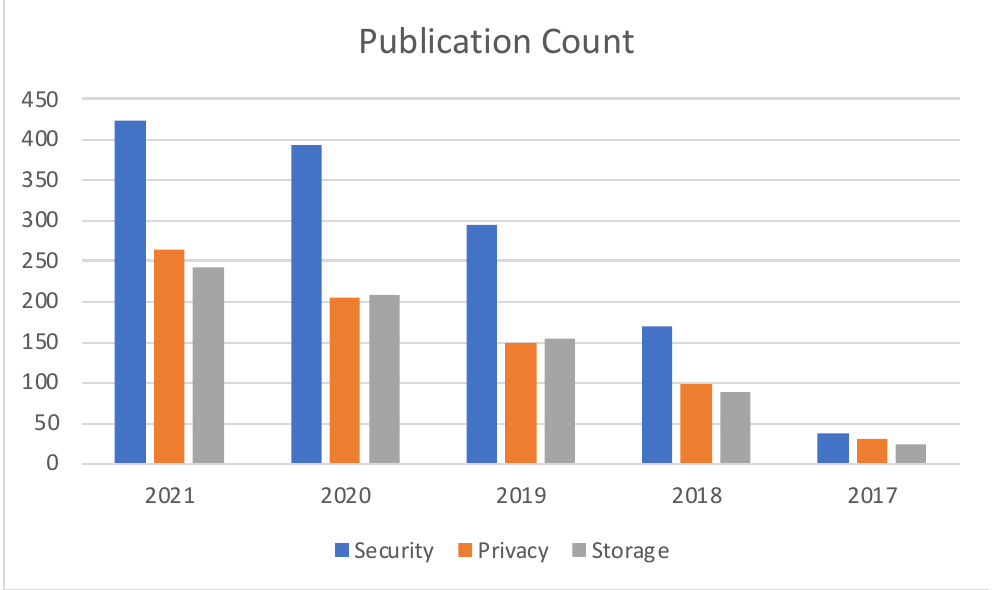
Figure 9. Year specific Publication Count comparison among Cloud impact areas.